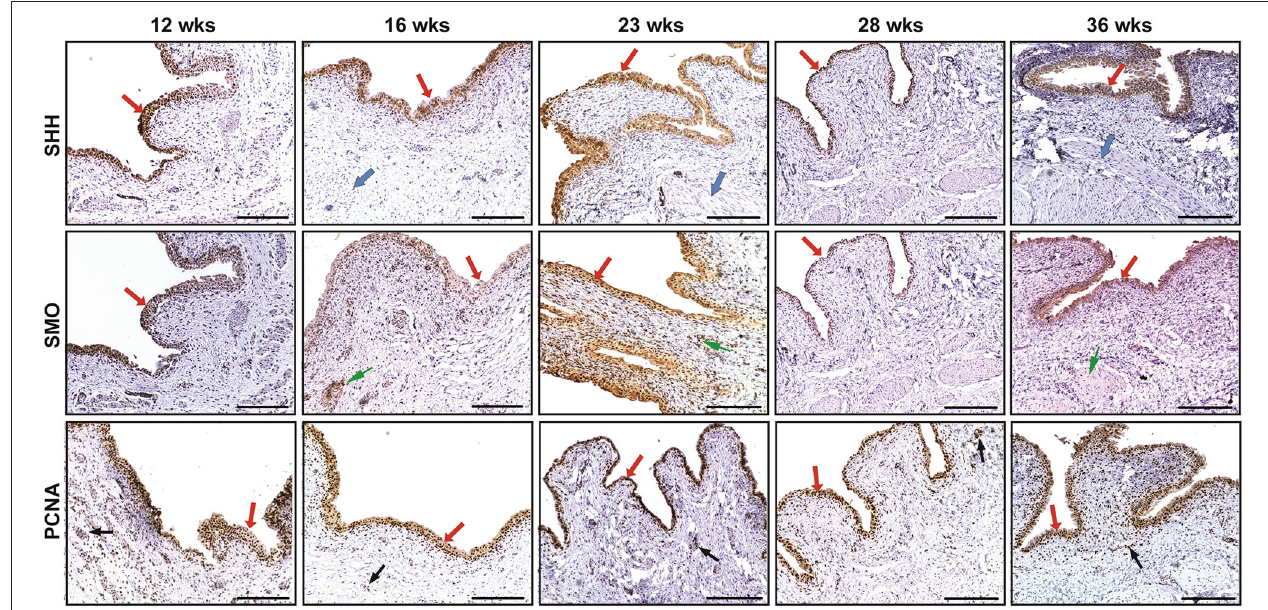
FIGURE 1 | The immunohistochemical staining of sonic hedgehog (SHH), smoothened (SMO), and proliferating cell nuclear antigen (PCNA) in human fetal bladders at different gestational weeks (wks). The expression of SHH and SMO was mainly detected in the developing bladder urothelial cells (see RED arrows), but not in the lamina propria layer. The expression of SHH could not be examined in the differentiating smooth muscle layer (see BLUE arrows); however, the minimal expression of SMO could be detected in them (see GREEN arrows). The expression of PCNA could be detected in the nucleus of the developing urothelium (see RED arrows) and mesenchymal cells (see BLACK arrows) of the fetal bladder with different expression levels. Scale bars: 100 µ m.